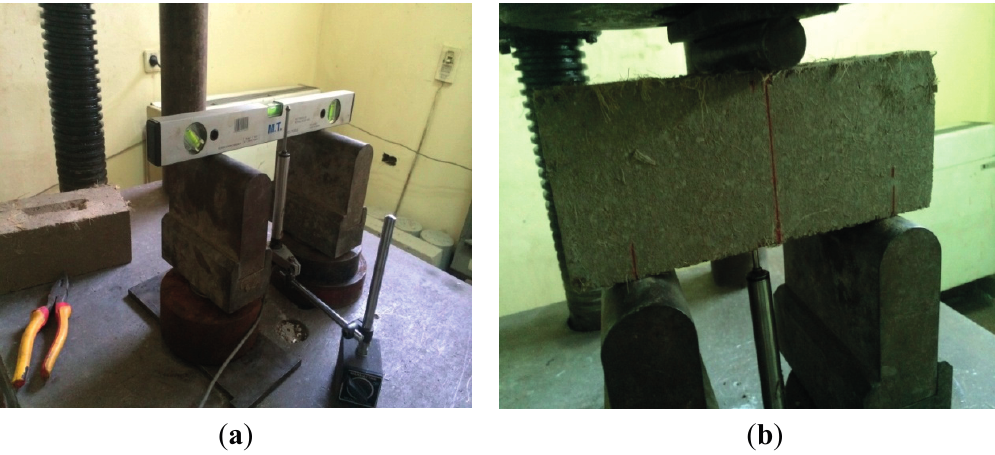
Figure 7. ( a ) Leveling the two supports and centering Linear Variable Differential Transformer (LVDT); ( b ) Flexural strength test